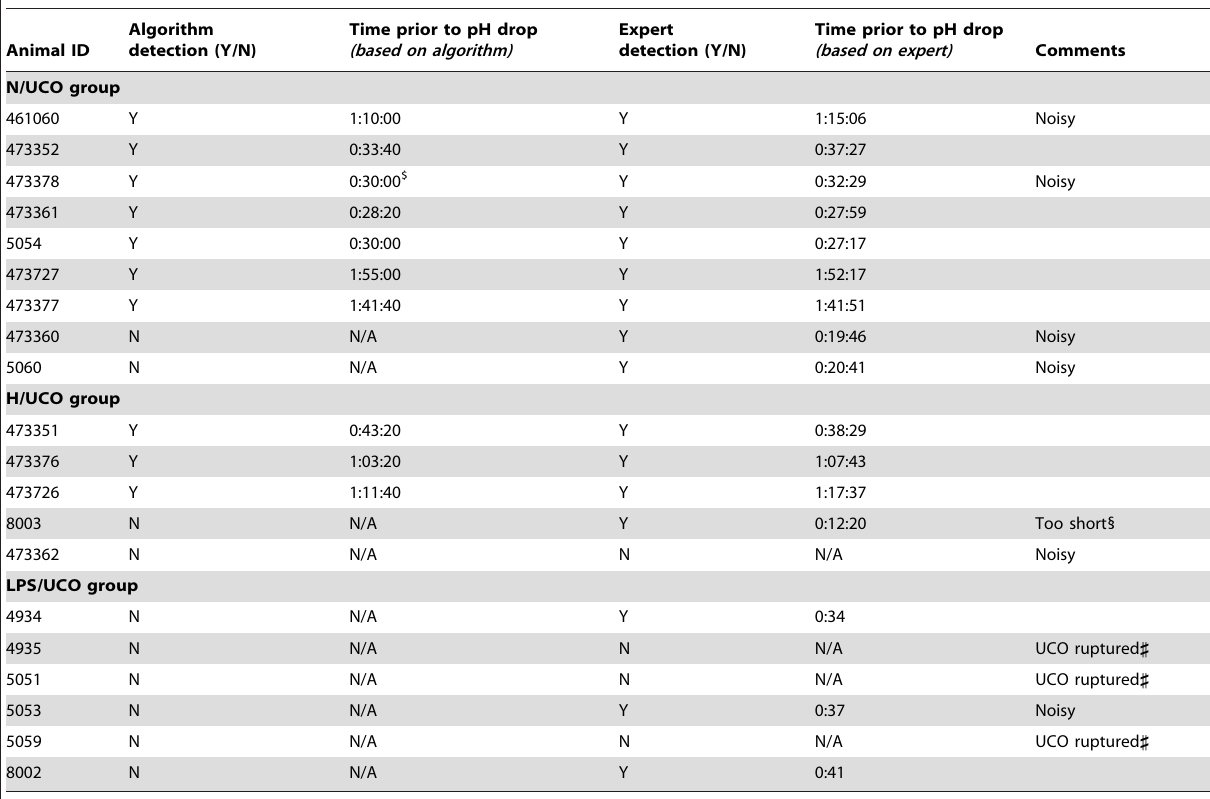
Table 2. Individual algorithm performance.